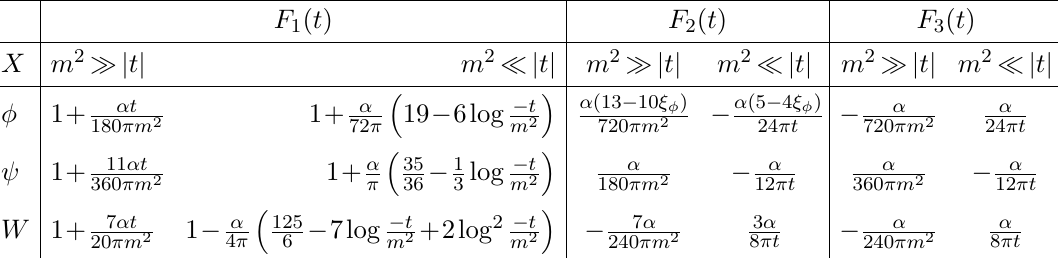
Table 3 . Large and small m limits of the form factors F i . The EFT parameter α 3 in eq. (1.12) is given by α 3 = − F 3 ( | t | (cid:28) m 2 )